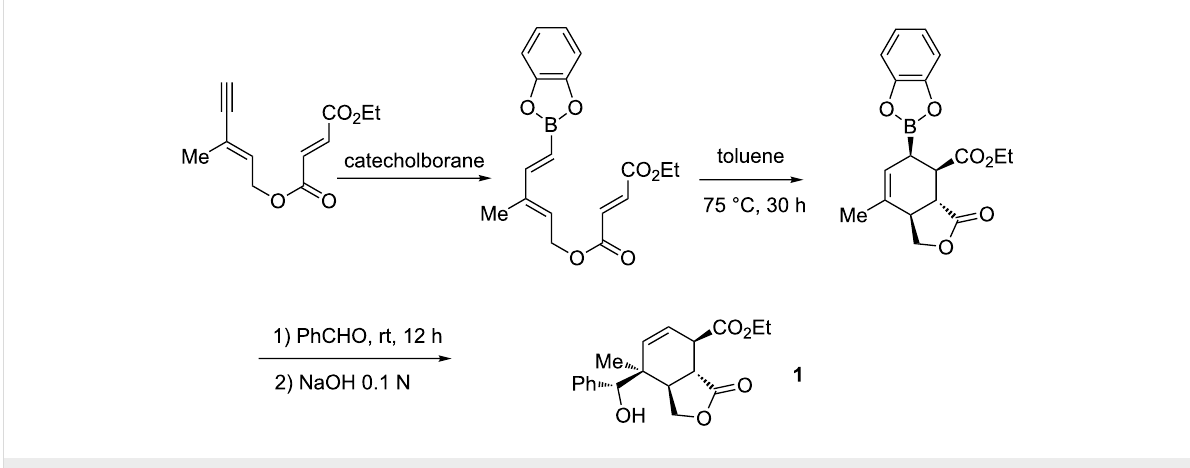
Scheme 4: Intramolecular Diels–Alder/allylboration sequence.